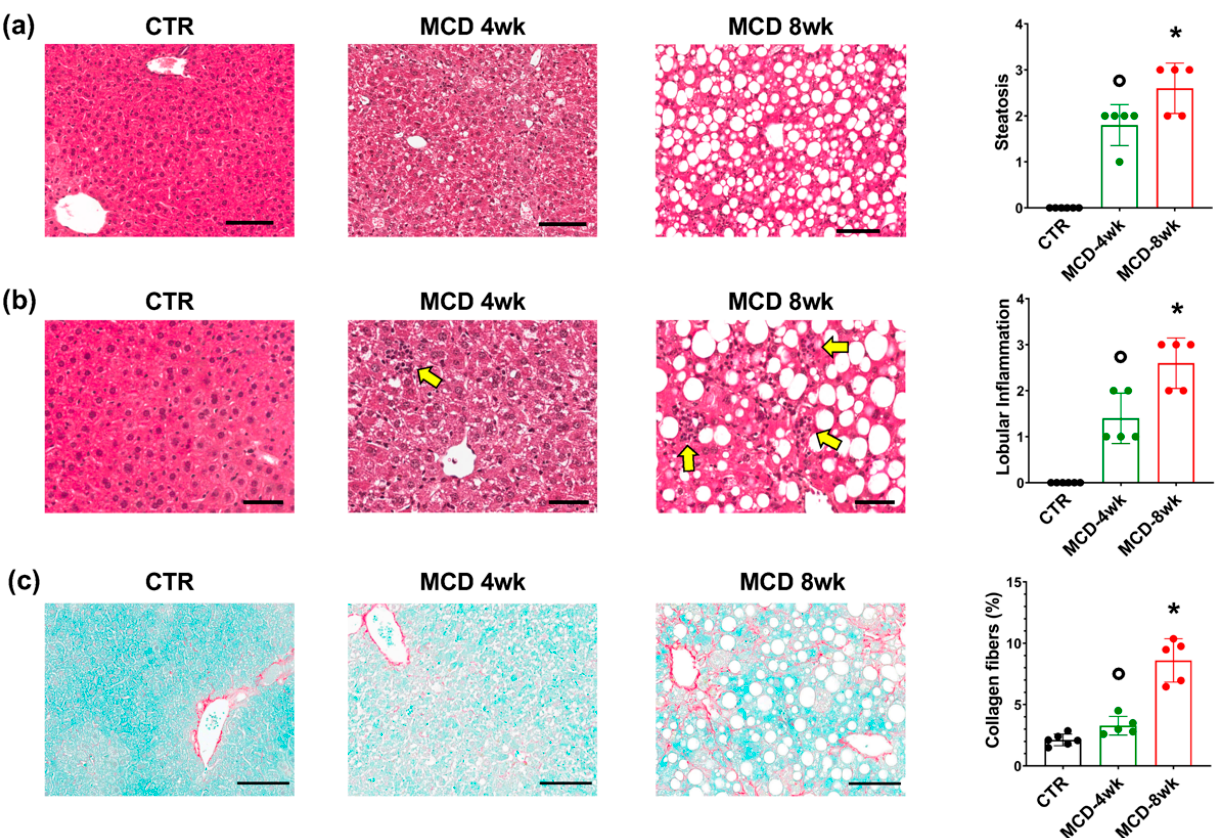
Figure 1. Histopathology of mice after methionine-choline-deficient (MCD) diet administration. ( a , b ) Hematoxylin and eosin (H&E) stain on MCD and control (CTR) mouse livers. In MCD mice, steatosis ( a ) and lobular inflammation (( b ), arrows) progressively increases after four weeks (4wk) and eight weeks (8wk) of MCD diet administration. I. Sirius red/fast green (SR/FG) stains in MCD and CTR mouse livers. Collagen deposition in mice livers increased after eight weeks of MCD diet administration. Scale bars: 100 µ m ( a,c ) and 50 µ m ( b ). In ( a – c ), histograms show means and standard deviations for steatosis and inflammation scores ( a , b ), and for the area percentage of the liver occupied by collagen fibers ( c ). Data from each animal are plotted as solid circles in the graph. * p < 0.05 vs. all other groups; ° p < 0.05 vs. CTR. 2.2. Effects of Calcium-Sulphate-Bicarbonate Water (W csb ) on Liver Histopathology in MCD Mice All MCD mice drinking calcium-sulphate-bicarbonate water (MCD/W csb ) were char- acterized by a certain degree of NASH histopathological features (i.e., steatosis, lobular inflammation, and fibrosis; Figures 2 and 3). Among mice sacrificed after 4 weeks of treatment, MCD/W csb mice showed significantly lower inflammation (score= 0.25 ± 0.5), fi- brosis (score= 0.25 ± 0.5) and collagen deposition (2.3 ± 0.4%) compared to MCD-4wk mice ( p < 0.05); no significant differences were observed in terms of steatosis (score= 1.3 ± 0.5) compared to MCD-4wk